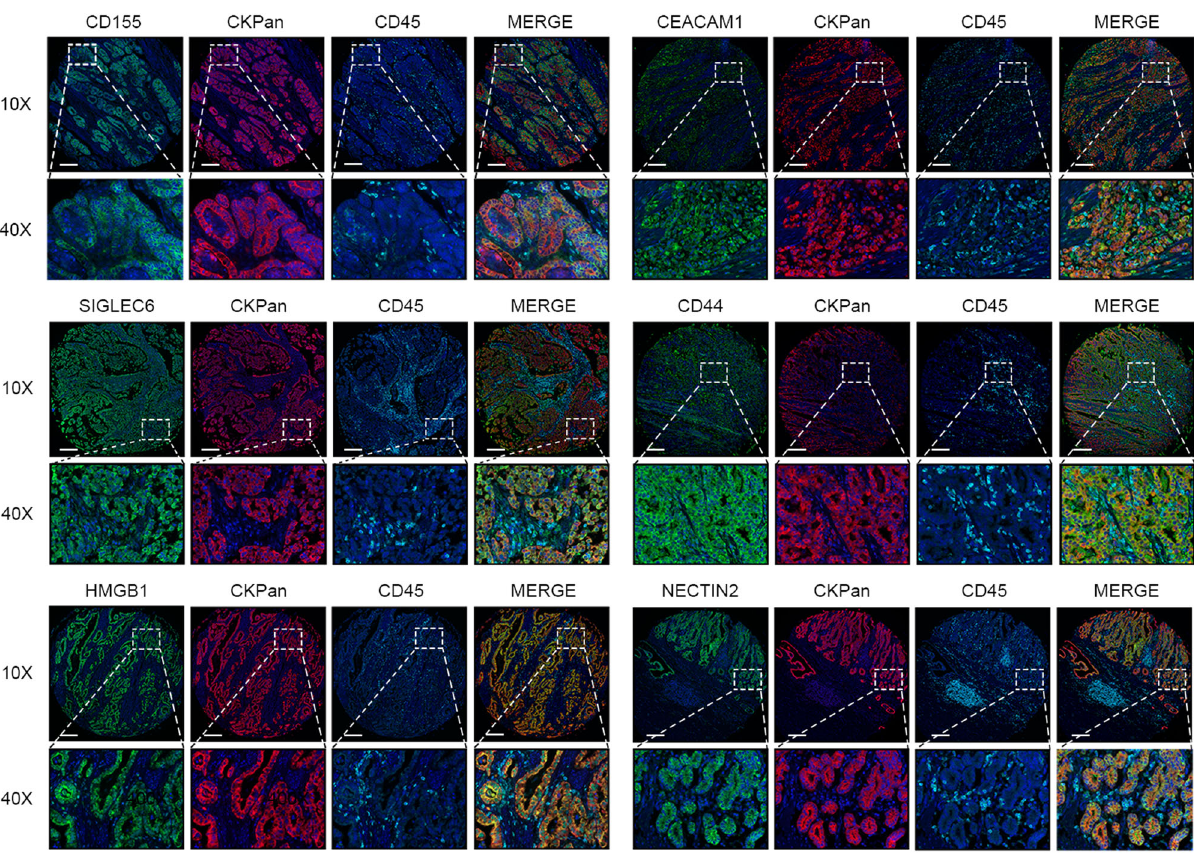
Fig. 2 The co-localization of 6 indicators (CD155, NECTIN2, CEACAM1, HMGB1, SIGLEC6, CD44), CD45 and gastric cancer CKpan. Multi-colour immuno fl uorescence staining of anti-CKpan and CD45 antibodies with CD155, NECTIN2, CEACAM1, HMGB1, SIGLEC6 or CD44 antibodies. Scale bar = 200 μ